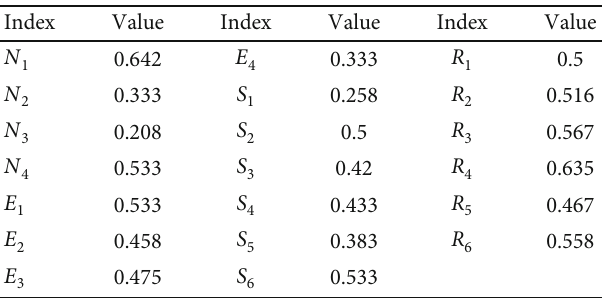
Table 6: Gas explosion vulnerability index score results obtained from